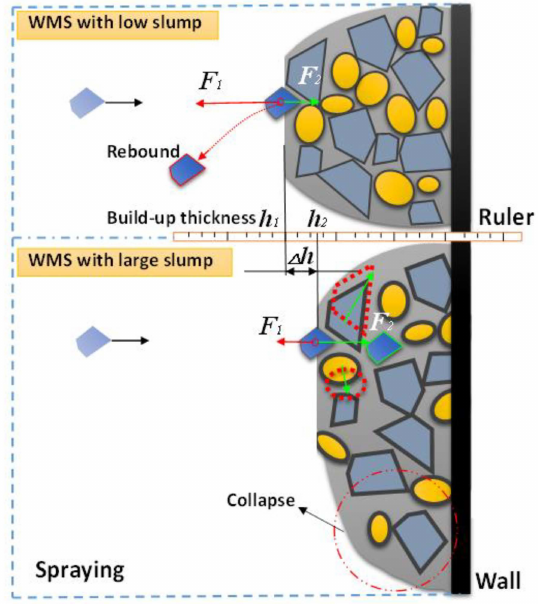
Figure 5. Shootability compression between low slump and large slump.